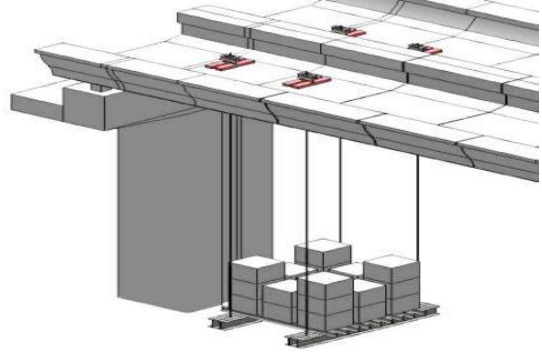
Figure 8. Side-span counterweight.